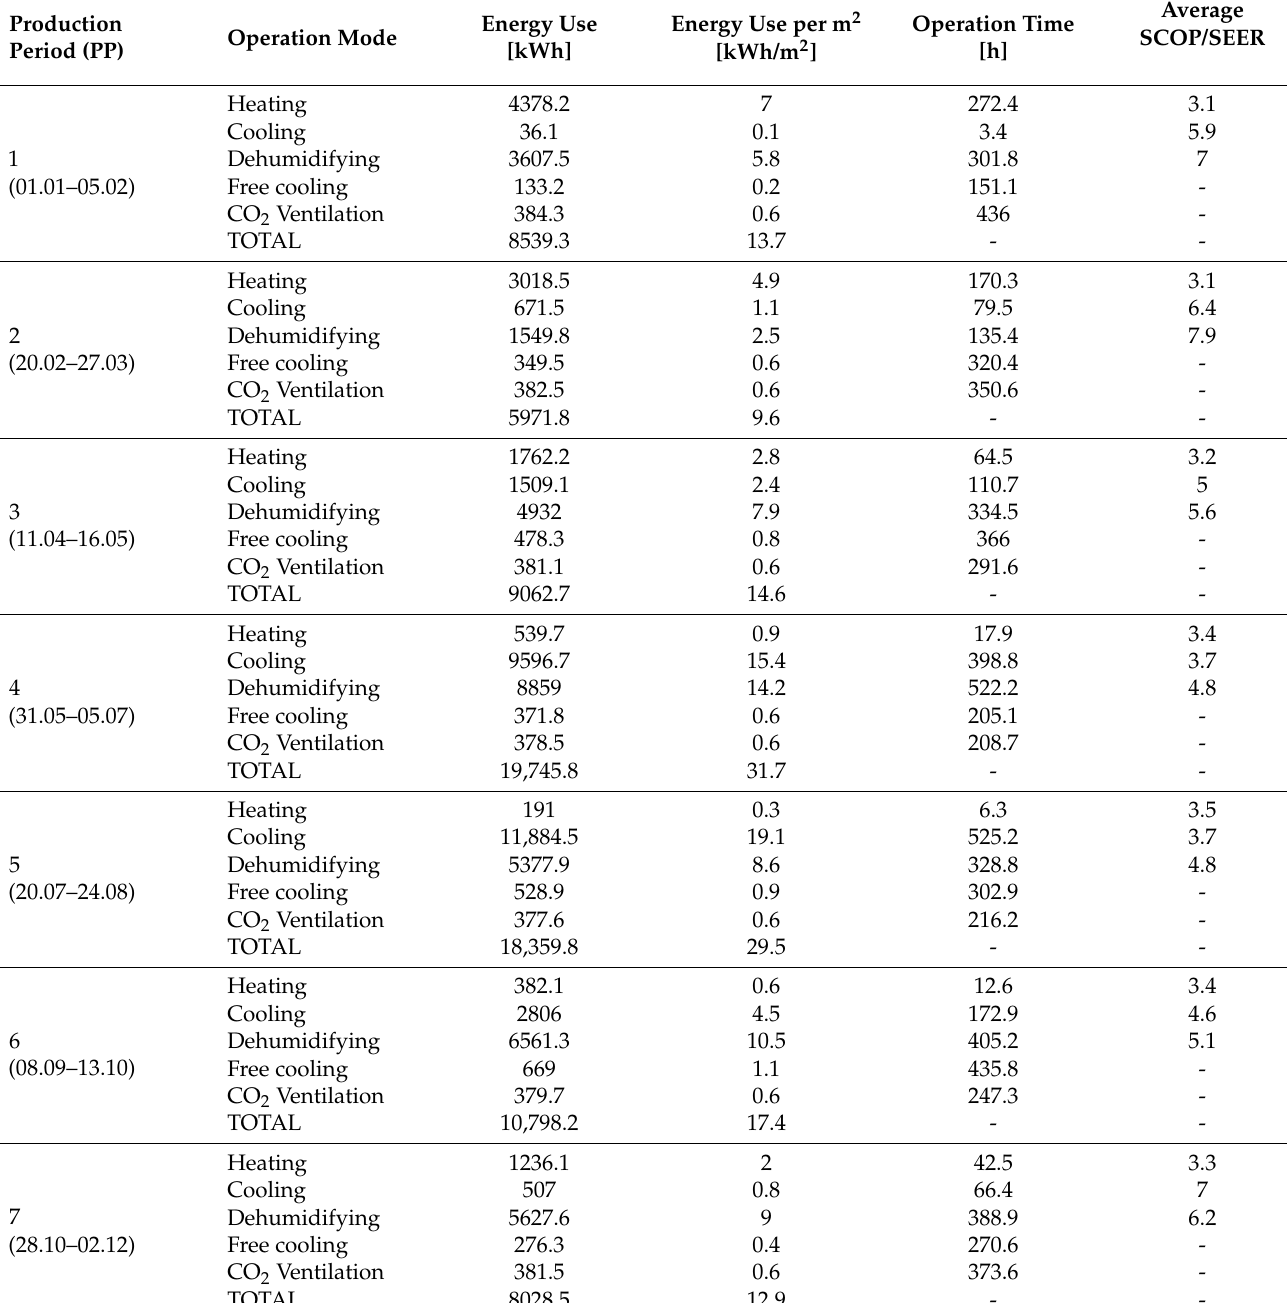
Table 5. Energy use and energy efficiency indicators of each operation mode per production